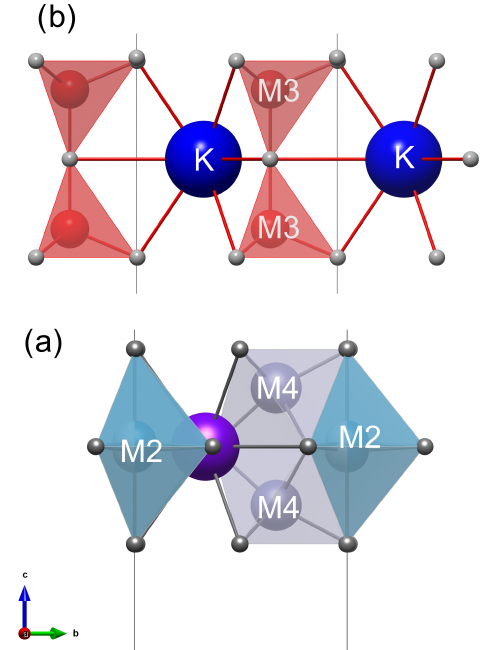
Figure 2. Conducting R blocks in (a) magnetoplumbite-type struc- ture with five coordinated M2 cations and (b) kahlenbergite with four coordinated M3